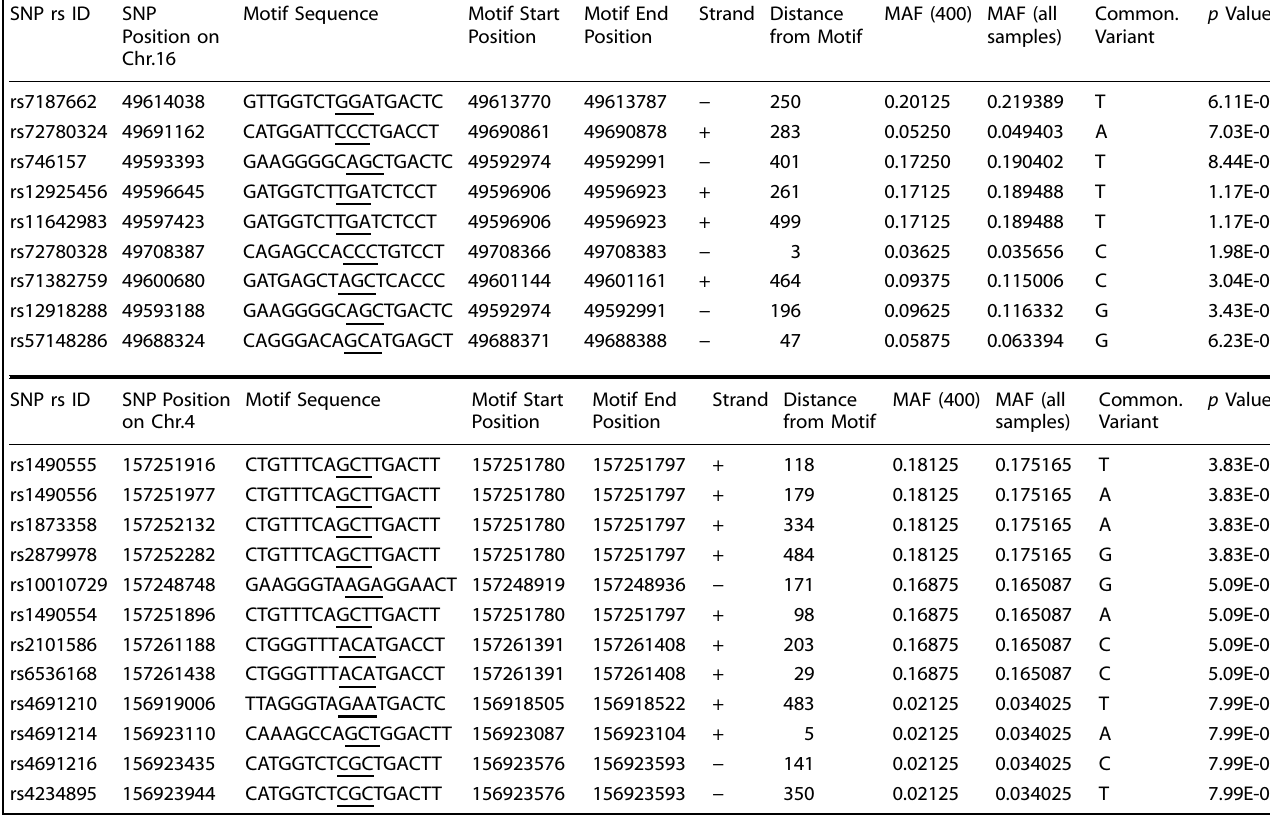
Table 1. SNPs across the ZNF423 gene on chromosome 16 and SNPs across the CTSO gene on chromosome 4 within ± 500 bp of ERE motifs with p values ≤ 10E-03. p values are for associations with the occurrence of breast cancer during SERM therapy SNP rs ID Motif Sequence Motif Start Motif End Strand Distance MAF (400) MAF (all Common. Position Position from Motif samples) Variant Chr.16